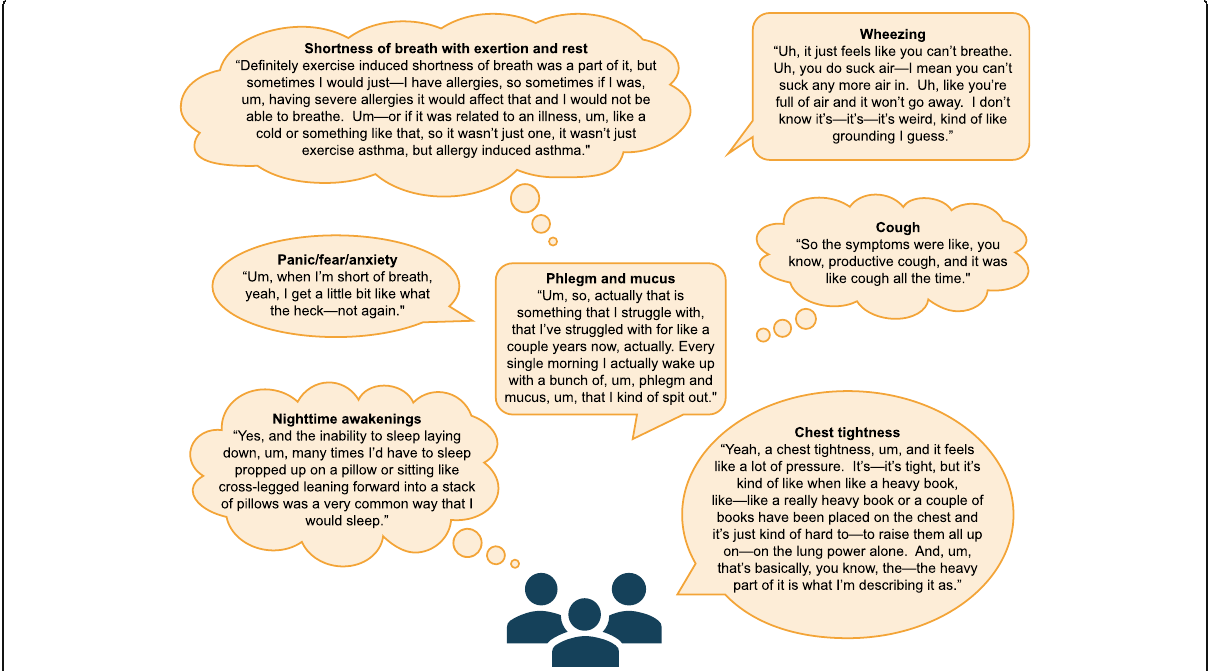
Fig. 2 Patient core descriptions of respiratory symptoms captured during concept elicitation interviews